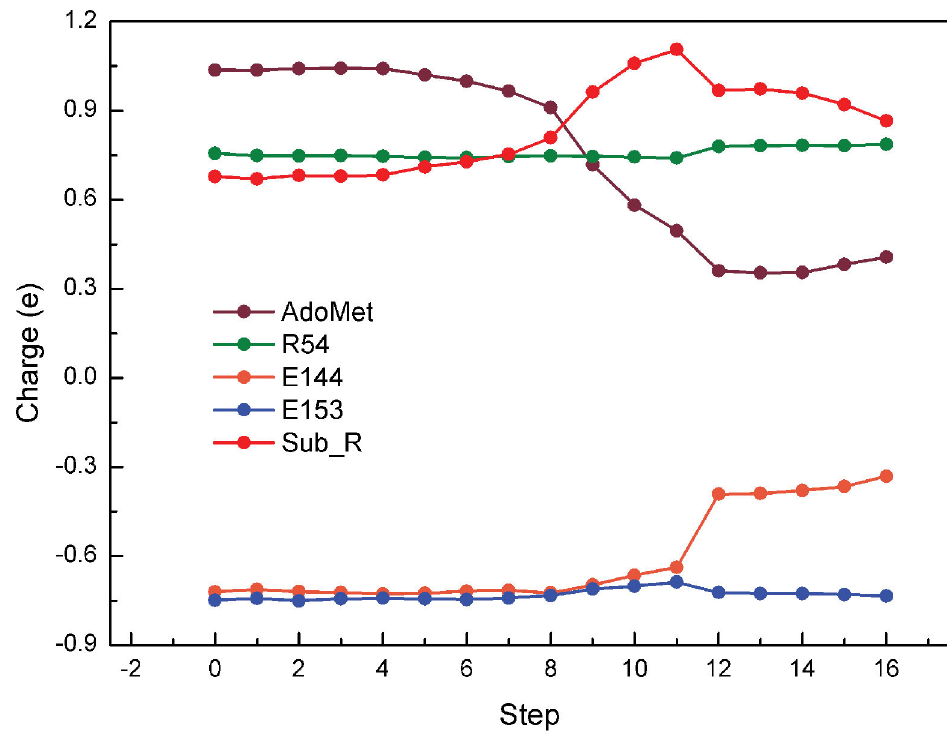
Figure 4. Evolution of electrostatic potential (ESP) charge distribution during the first methyl transfer. (R: Reactant, TS: S 2 transition state, P: N